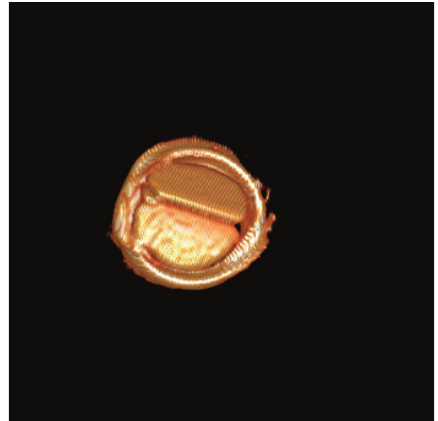
Figure 5: Metallic mechanic prosthetic valve by CT : 3-D VRT reconstructions permit the evaluation of leaflet dysfunction and valve obstruction. Here: St. Jude mechanic aortic valve, closed during diastole (normal finding). These valves cause artifacts of echo; hence, CT can act as troubleshooter in case of suspected dysfunction or infection.